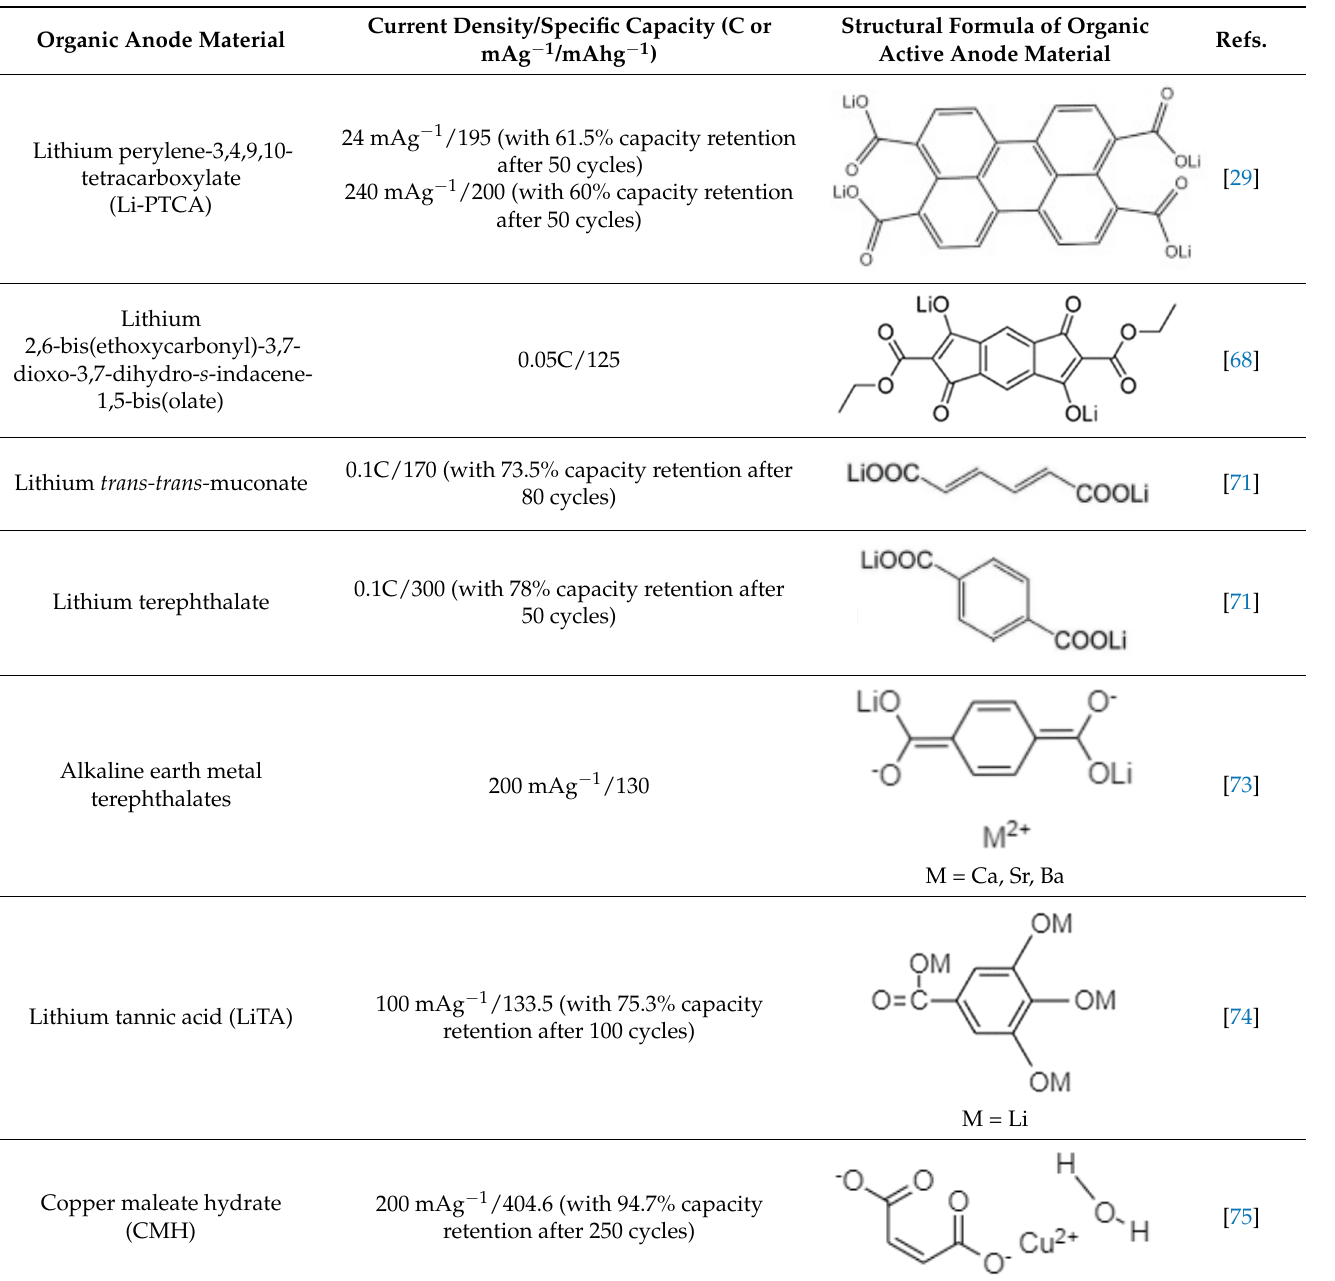
Table 1. Structural formulas of typical organic anode materials based on carbonyl compounds and their key electrochemical parameters.